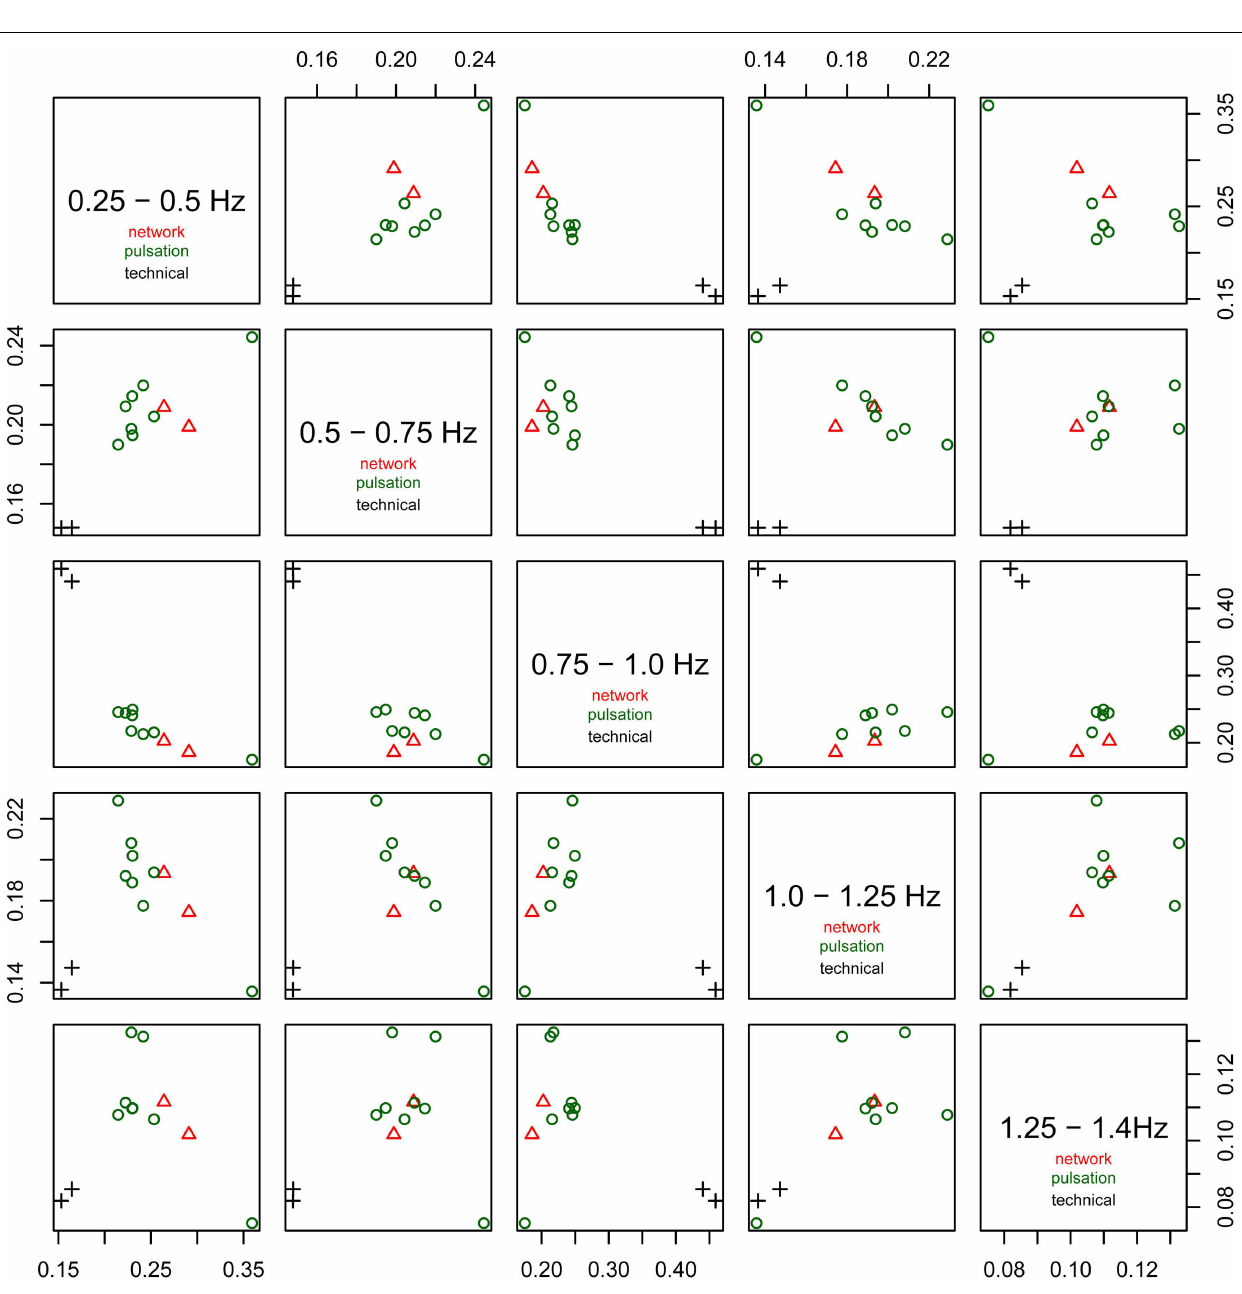
FIGURE 6 | Fractional amplitude of fluctuations in frequency bands 0.25–0.5, 0.5–0.75, 0.75–1.0, 1.0–1.25, and 1.25–1.4Hz plotted against each other for all consistent tICA components . Note that technical artifacts can easily be separated from all other components in the frequency bands